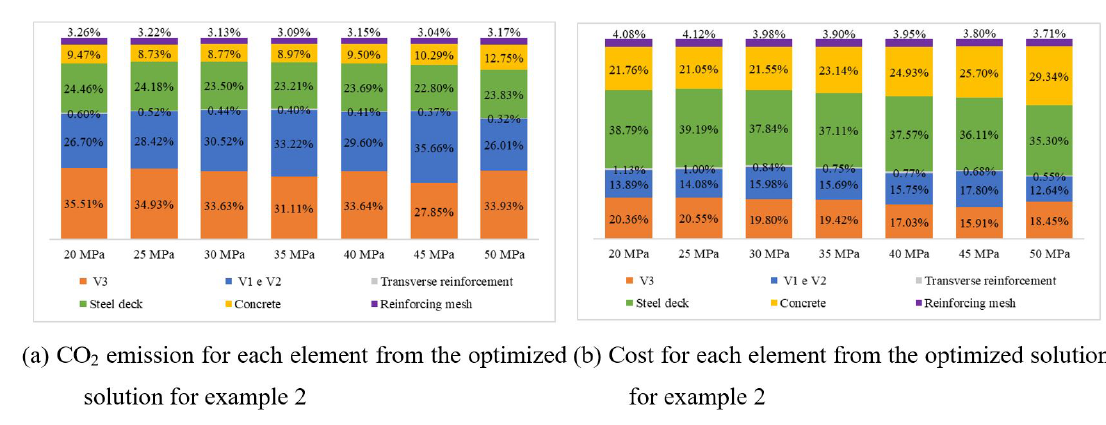
Figure 10. Optimized solution for example